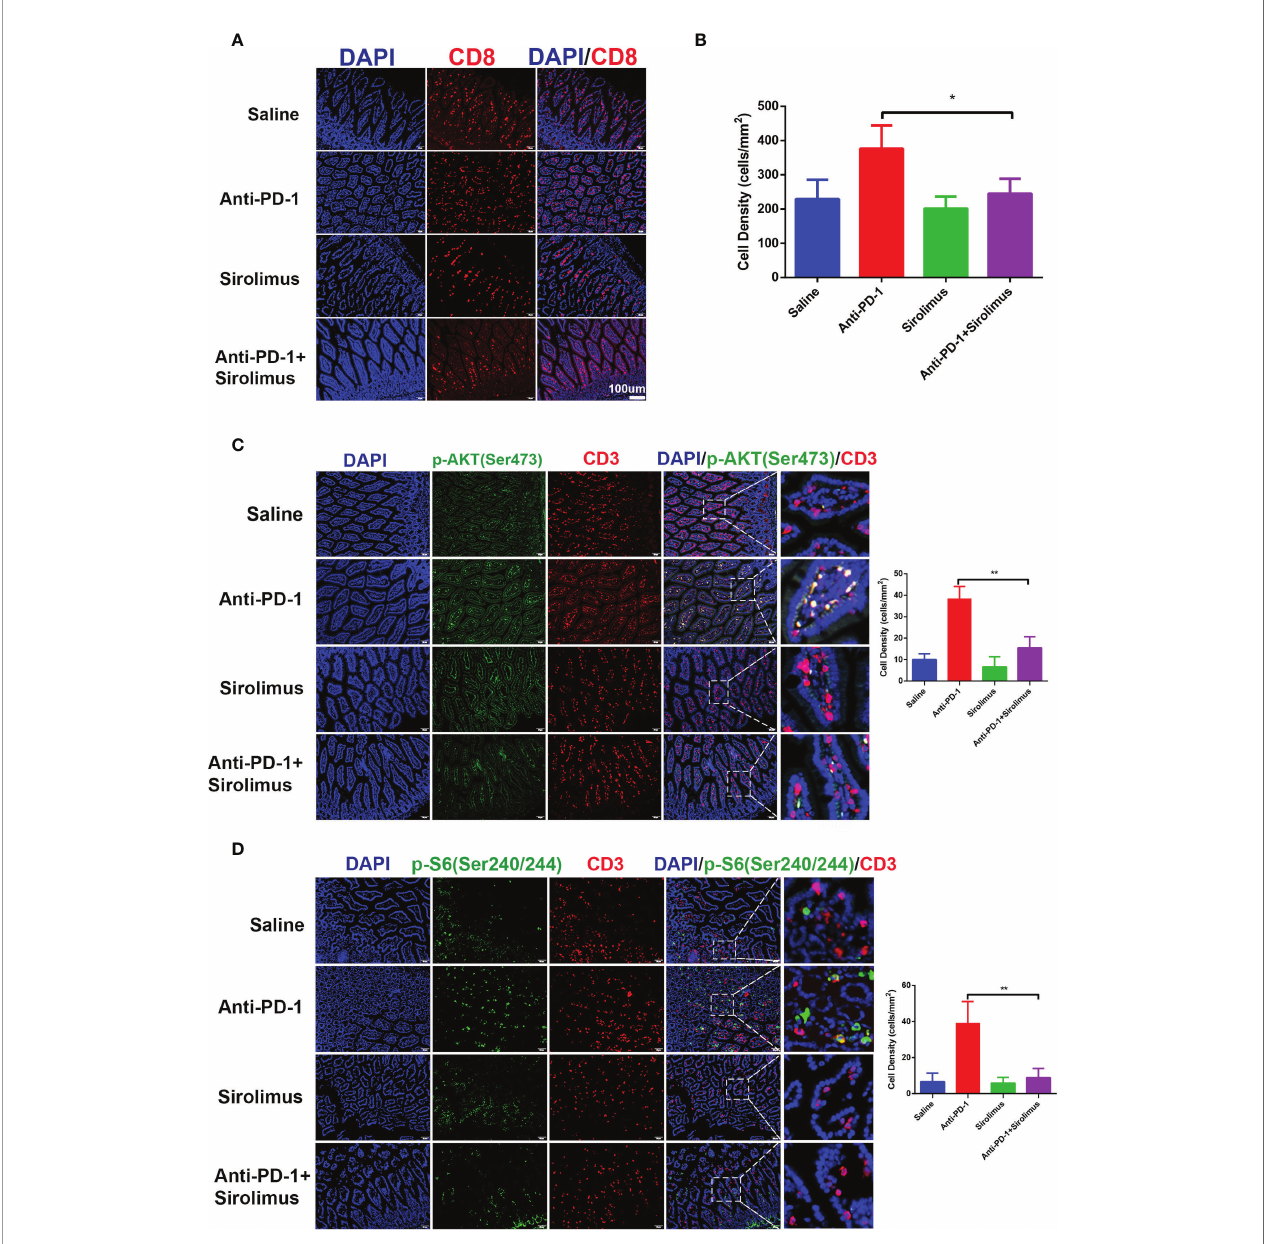
FIGURE 5 | CD8 + T cells in fi ltration and activation of PI3K-AKT-mTOR pathway were reduced by sirolimus. (A) Immuno fl uorescence staining showed the in fi ltration of CD8 + T cells in colon was reduced by sirolimus. CD8 is shown in red and DAPI in blue. Scale bar 100 m m. (B) The densities of CD8 + T cells in each group were quanti fi ed. The results were presented as mean ± SD (n=4). * p < 0.05. (C) Double immuno fl uorescent staining with CD3 and phosphor-AKT (Ser 473) antibodies counterstained with DAPI on FFPE colon sections. CD3 is shown in red, phosphor-AKT (Ser 473) in green, and DAPI in blue. Scale bar 100 m m. ** p < 0.01. (D) Double immuno fl uorescent staining with CD3 and phosphor-S6 Ribosomal Protein (Ser 240/244) antibodies counterstained with DAPI on FFPE colon sections. CD3 is shown in red, phosphor-S6 Ribosomal Protein (Ser 240/244) in green, and DAPI in blue. Scale bar 100 m m. ** p <